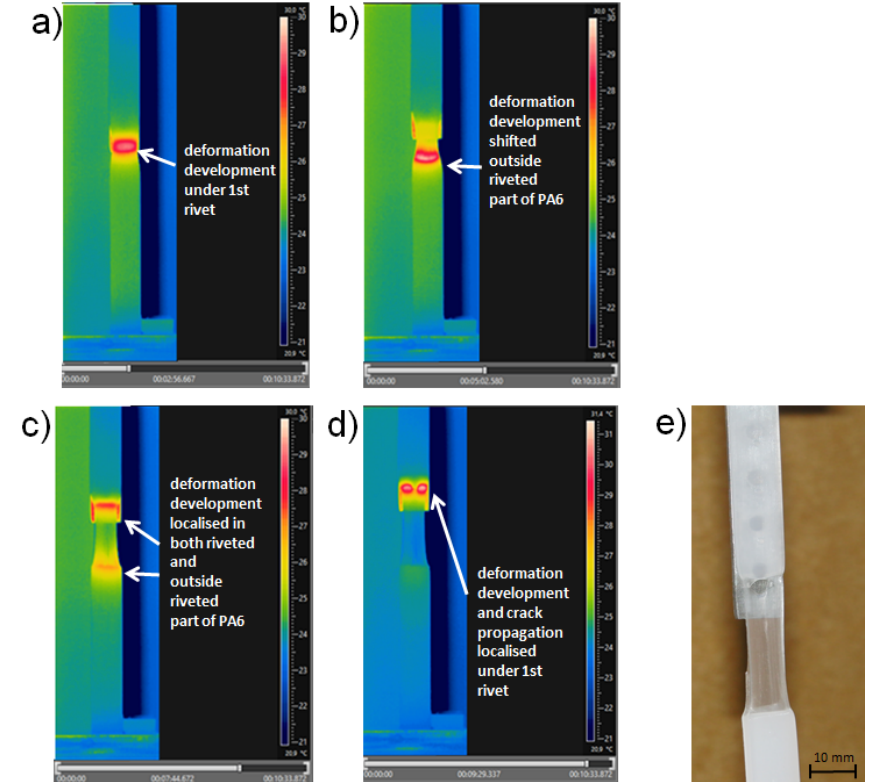
Figure 6. IR thermograms for sample coupled with four rivets during lap-shear test, pictures viewed in time sequence after test began: ( a ) 2 min 56 s; ( b ) 5 min 2 s; ( c ) 7 min 44 s; and ( d ) 9 min 29 s. ( e ) Picture of sample with neck and crack formation.